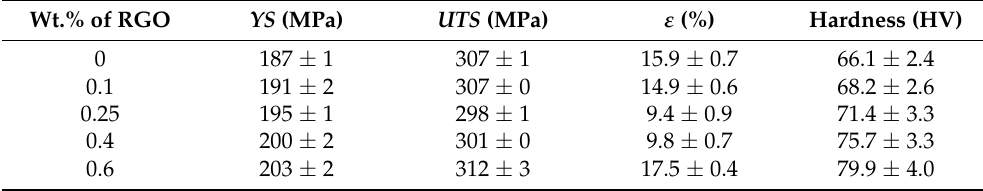
Figure 10. ( a ) Vickers hardness of RGO-reinforced ZK61 matrix composites with increasing content of RGO. ( b ) Tensile stress–strain curves of ZK61 alloy and the composite with 0.6 wt.% RGO addition. Table 1. Mechanical properties of RGO/ZK61 composites at ambient temperature.